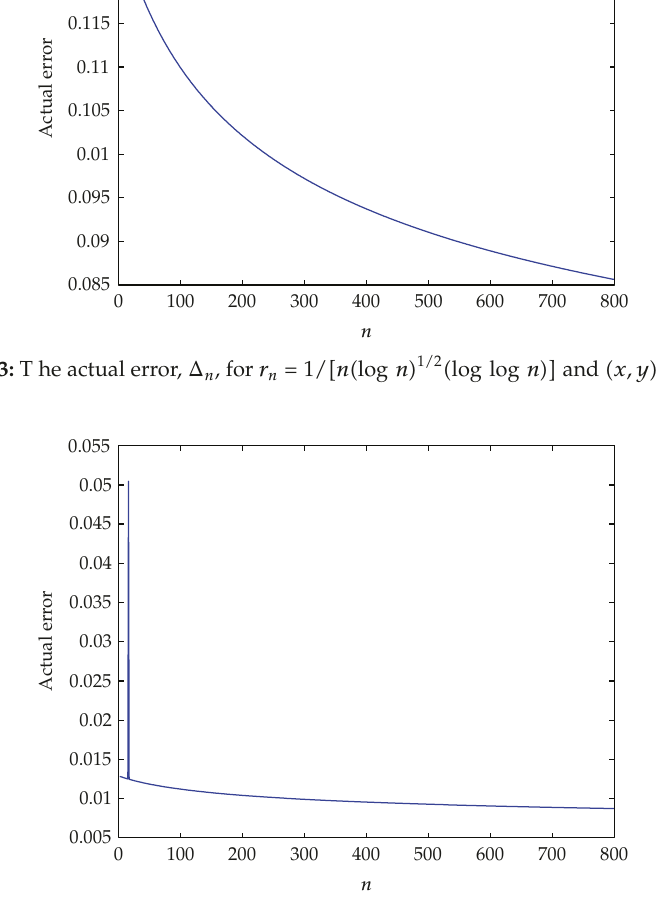
Figure 4: T he actual error, Δ n , for r n (cid:4) 1 / (cid:5) n (cid:2) log n (cid:3) 1 / 2 (cid:2) log log n (cid:3)(cid:2) log log log n (cid:3)(cid:6) and (cid:2) x,y (cid:3) (cid:4) (cid:2) − 1 , − 1 (cid:3)